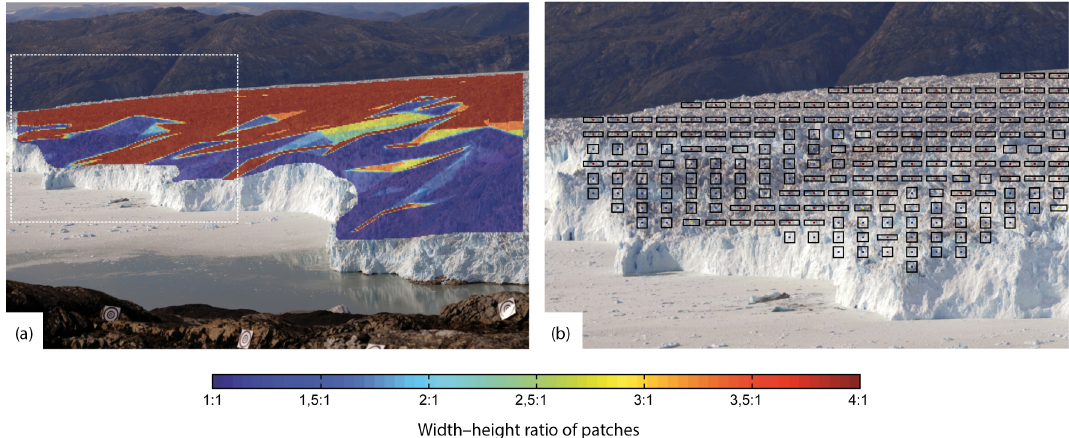
Figure 4. Locally adaptive patch sizes. The figure shows the result of the automatic patch size definition taking into account distance differences in the patch. (a) The determined aspect ratios for a patch are shown colour-coded at the corresponding position in the image. For a smaller image excerpt (white rectangle), the resulting patches (black contour) are superimposed on the sequence image (b) .